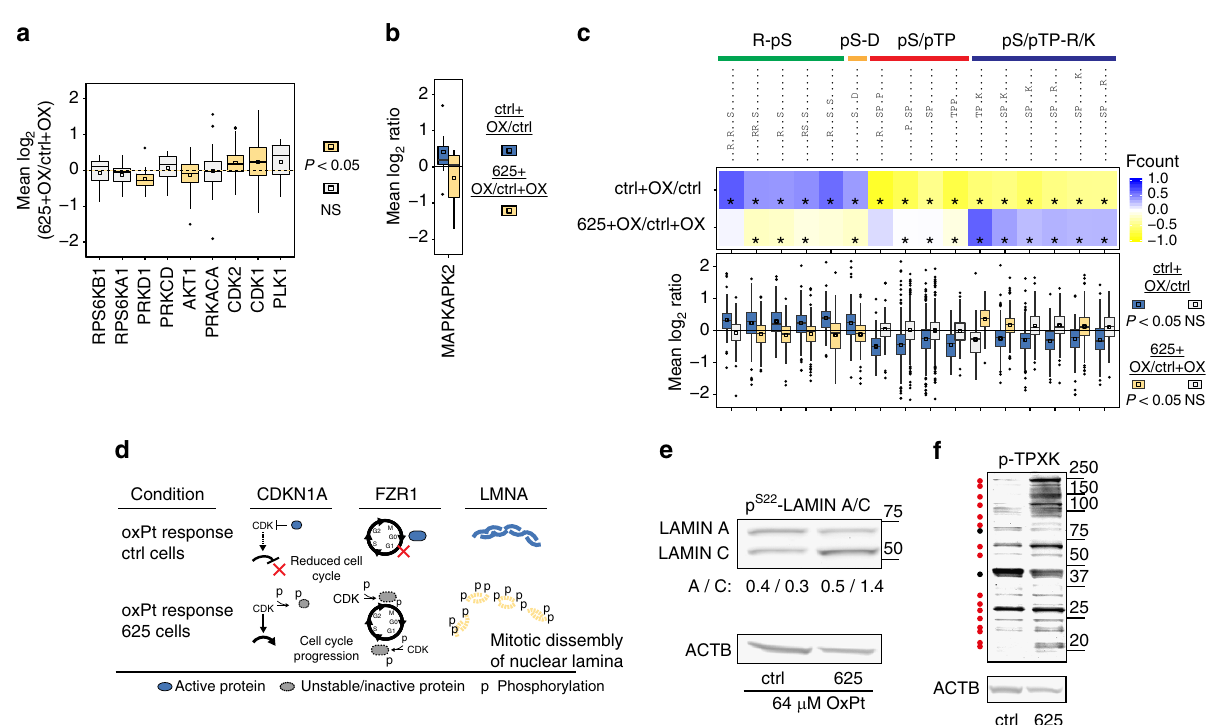
Figure 9 | Critical components of the cellular response to oxPt are blocked in cells with increased miR-625-3p levels. ( a ) Mean log 2 ratios of substrates groups involved in oxPt response were calculated for the 625 þ OX/ctrl þ OX data. ( b ) Mean log 2 for the MAPKAPK2 substrate group. ( c ) The most significantly altered substrate phosphorylation motifs identified for the ctrl þ OX/ctrl and 625 þ OX/ctrl þ OX experiments identified using KSEA (displayed as fcounts, P r 0.05 indicated with "*"). Mean log 2 ratios for substrates with these motifs were calculated. Coloured boxes in the boxplots of a , b and c indicate P r 0.05, z-test; and NS, not significant. On the basis of similarity, the 16 individual motifs were grouped into the four motif groups indicated above. Note that the experimental mean log 2 ratios for clarity have been omitted in b and c . ( d ) oxPt treatment in HCT116.ctrl cells led to dephosphorylation of Serine 130 (S130) of Cyclin-Dependent Kinase Inhibitor 1 (CDKN1A, also known as p21 CIP1 ), which has been linked to increased stability of CDKN1A and inhibition of CDK/cyclin-mediated cell cycle progression 65 . In contrast, increased S130 phosphorylation was seen in cells with ectopic miR-625-3p expression. As indicated, this phosphorylation may itself be mediated by elevated CDK activity 66 . Increased CDK activity at the G1/S checkpoint or in early M phase was also indicated by S138/S151 phosphorylations on inactivated FZR1 (also known as CDH1) in miR-625-3p expressing cells, whereas unphosphorylated FZR1 in control cells suggested decreased CDK signalling at G0 or early G1 (ref. 67). In support of mitotic- induced nuclear lamina breakdown, increased phosphorylation was observed on multiple residues on LMNA in miR-625-3p cells; On the contrary, these became dephosphorylated after oxPt treatment in control cells indicating decreased cell cycle progression (also see Supplementary Fig. 14). ( e ) Western blotting against the CDK1 substrate phospho-LAMIN A/C S22 on lysates from oxPt-treated HCT116.ctrl and HCT116.625 cells. Quantification of bands representing Lamin A and C isoforms are indicated (normalized to b -actin signal). ( f ) Western blotting against the phosphorylated CDK motif p-TPXK on lysates from oxPt-treated HCT116.ctrl and HCT116.625 cells. Individual substrates are indicated with a dot with red and black indicating increase or decrease/no change in intensity, respectively, in HCT116.625 as compared with HCT116.ctrl